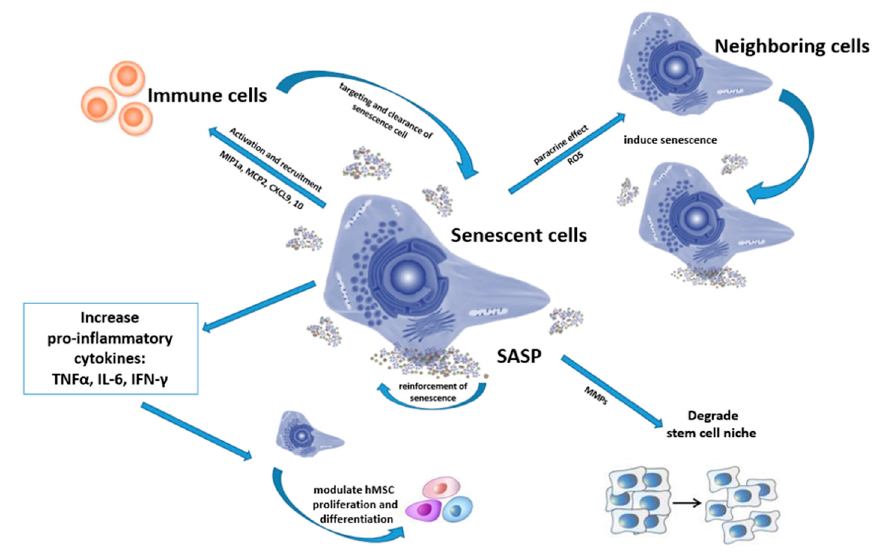
Figure 1. SASP effects on MSCs and their Figure 1. SASP e ff ects on MSCs and their microenvironment.